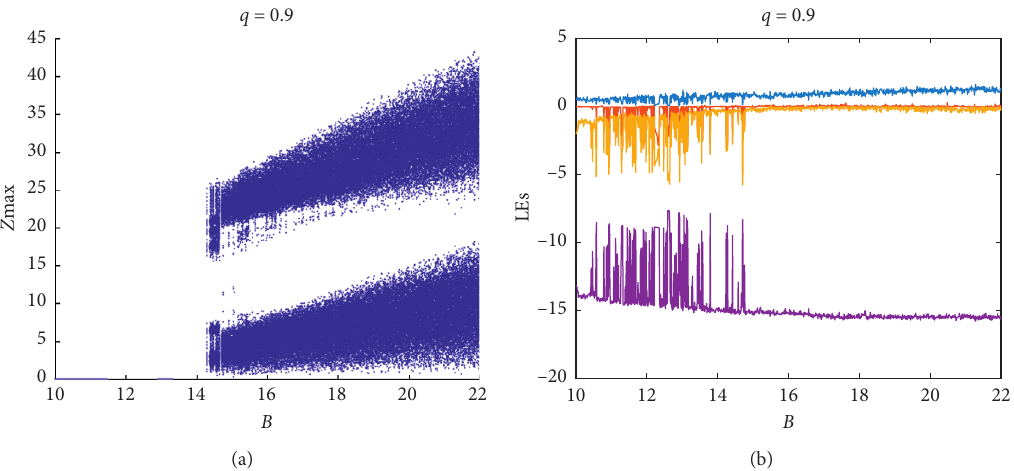
Figure 7: (a) Bifurcation diagram of parameter B of system (1) with q � 0.9; (b) Lyapunov exponent spectrum of parameter B of system (1) with q �